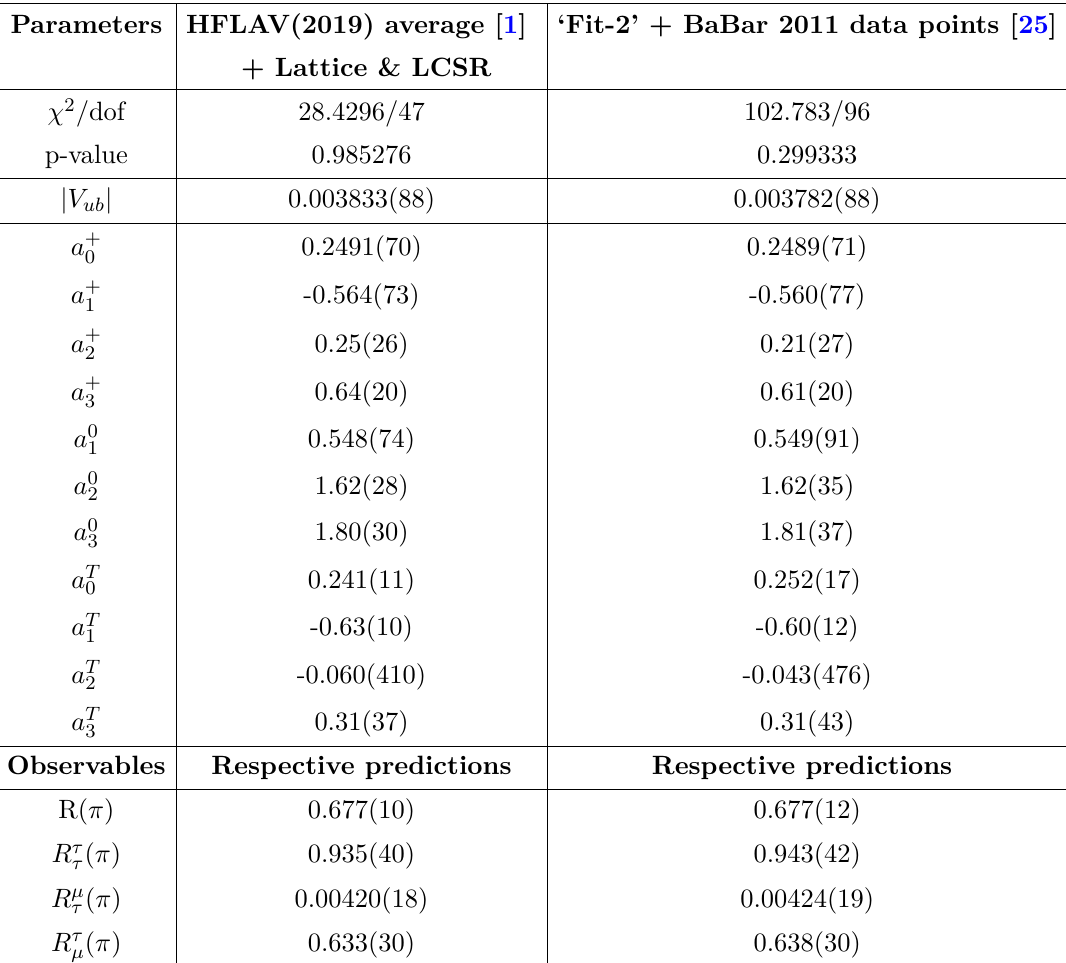
Table 2. Predictions of the observables defined in eqs. (2.9) corresponding to the fits of the 2019 averaged B → π binned dataset given in HFLAV [1] along with the inputs from lattice and LCSR (second column) and with all the data points defined in ‘Fit-2’ plus the BaBar 2011 data points [25] (third column). In we have not considered tensorial inputs. The last four rows presents the predictions of the observables in the two fits,